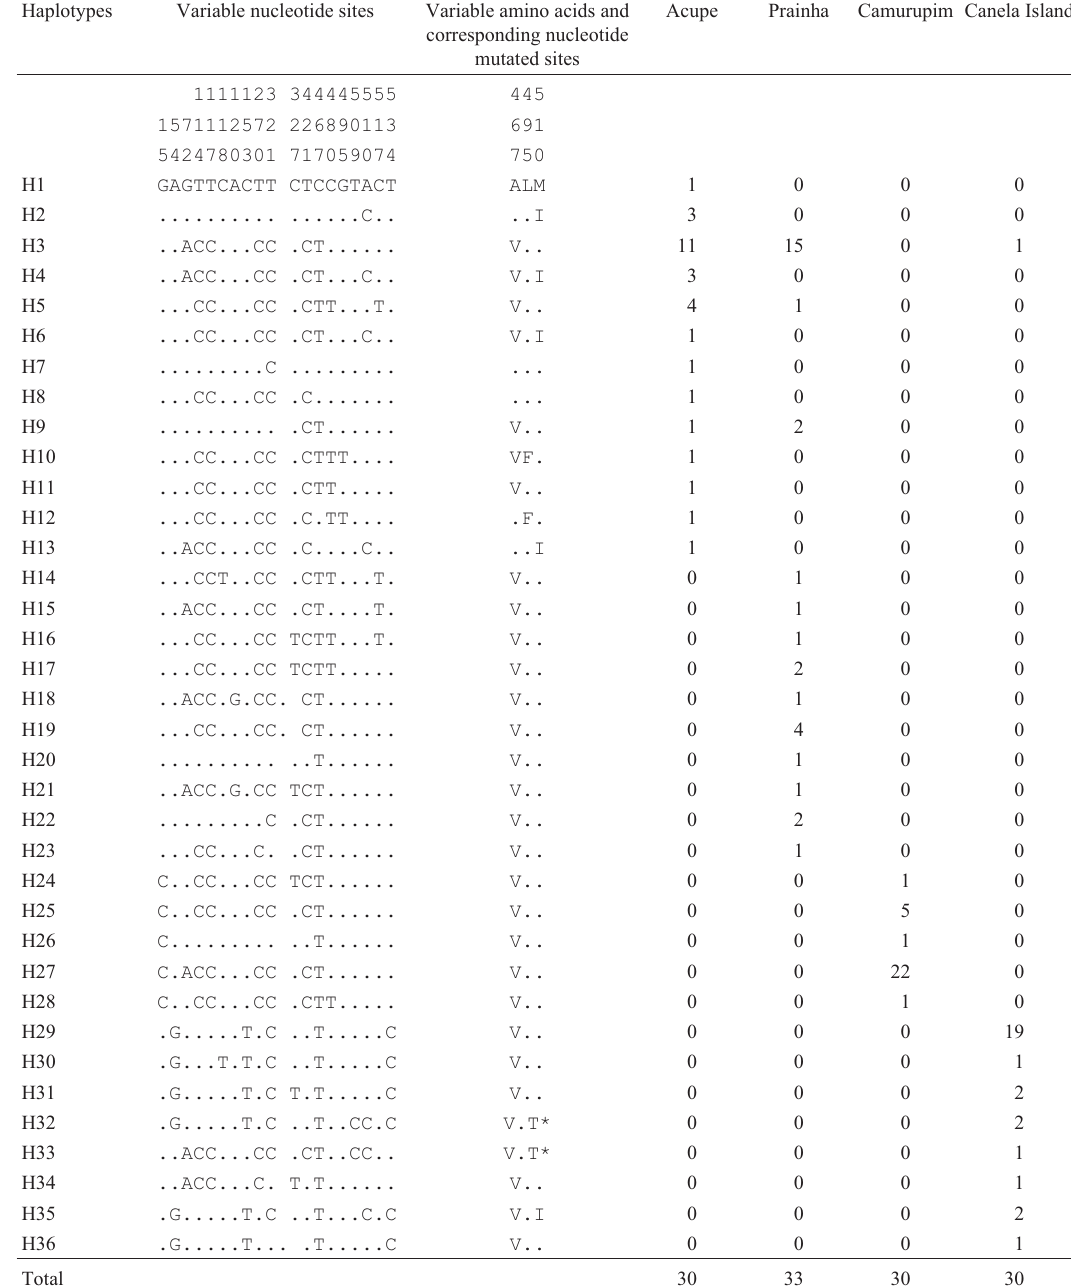
Table 1 - COI gene haplotypes from samples of Anomalocardia brasiliana showing the variable nucleotide and amino acid sites, and the number of indi- viduals carrying each haplotype. Haplotypes Variable nucleotide sites Variable amino acids and corresponding nucleotide mutated sites